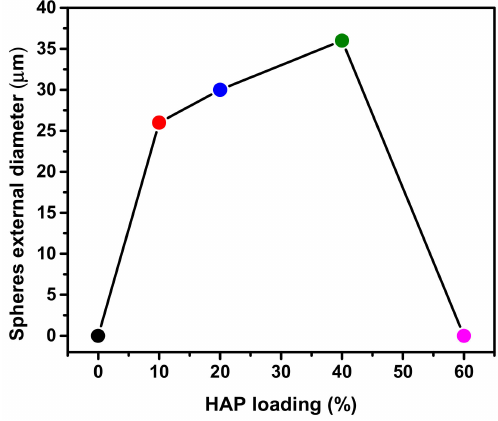
Figure 5. The external diameter of the sphere-like HAP@MgO as obtained from the SEM study as a function of HAP